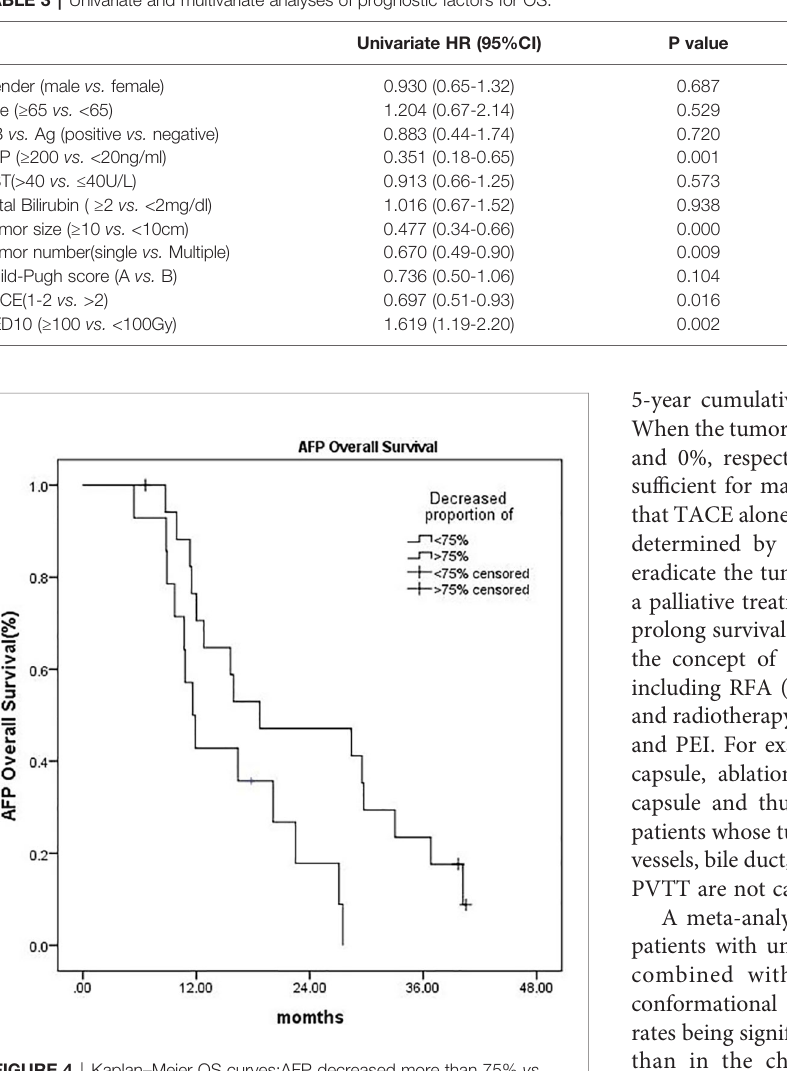
FIGURE 4 | Kaplan – Meier OS curves:AFP decreased more than 75% vs. AFP decreased by less than 75% (P =